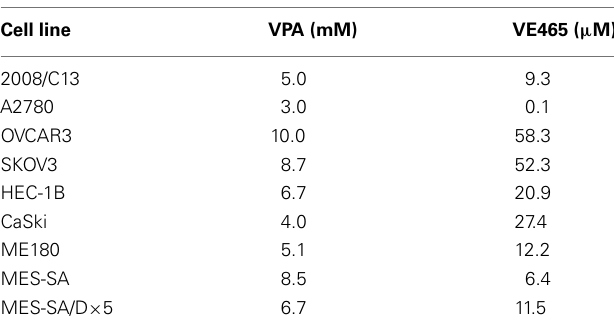
Table 1 | IC 50 ofVPA andVE465 after 72h of treatment in various cell lines.